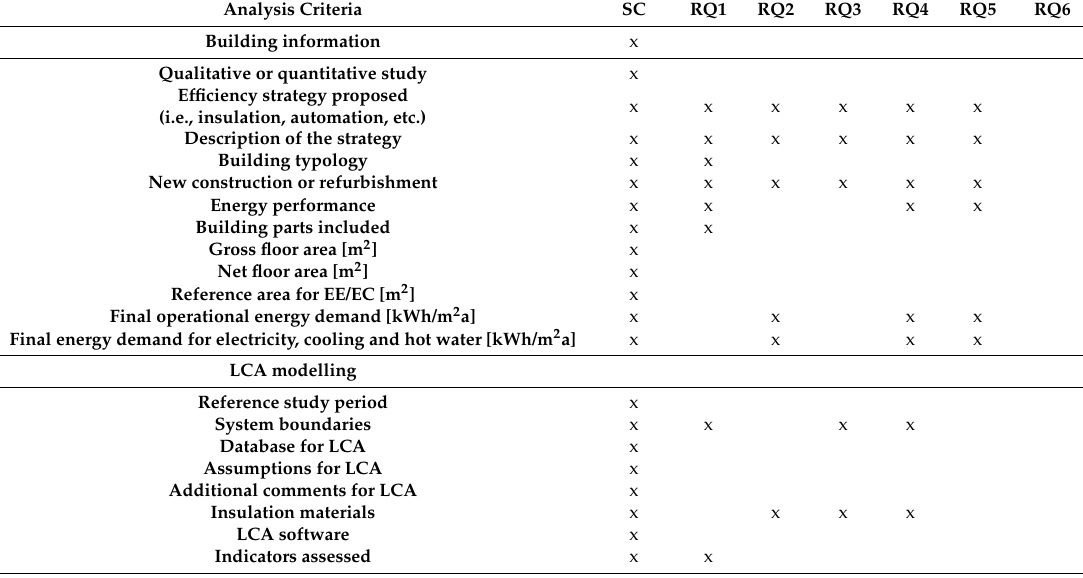
Table 1. Overview of analysis criteria used in the scope of the review to address the research questions (RQ). Supporting criteria and information (SC), necessary to compare the reviewed studies, are also